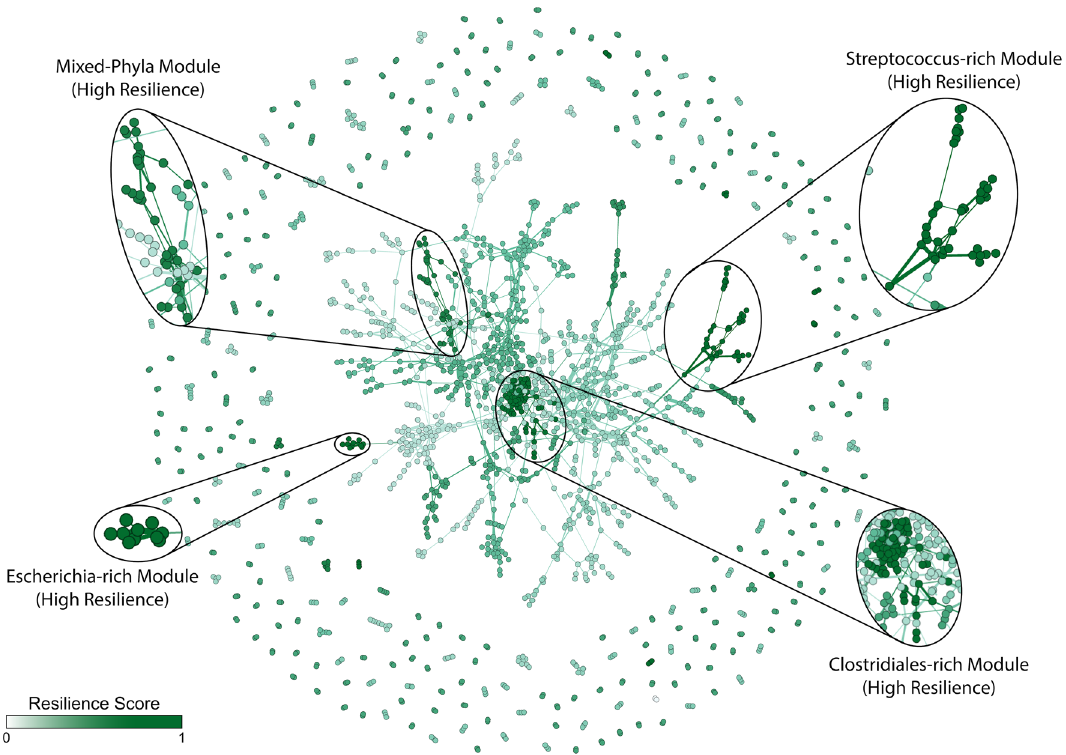
Figure 5. Microbiome association network, colored by module resilience. Module resilience scaled between [0,1] with lighter color modules represent lower module resilience, and darker color modules represent higher module